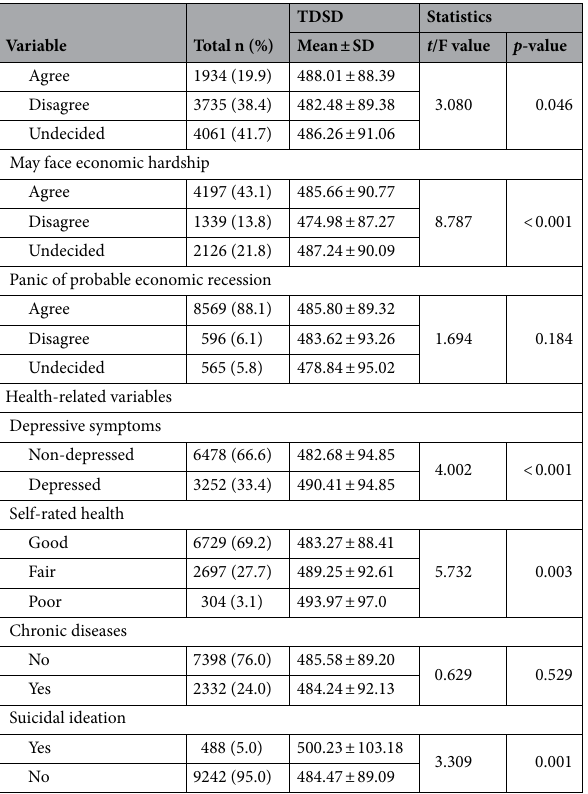
Table 1. Association between the study variables and total daily sleep duration (in minutes/24 h). TDSD, total daily sleep duration; SD, standard